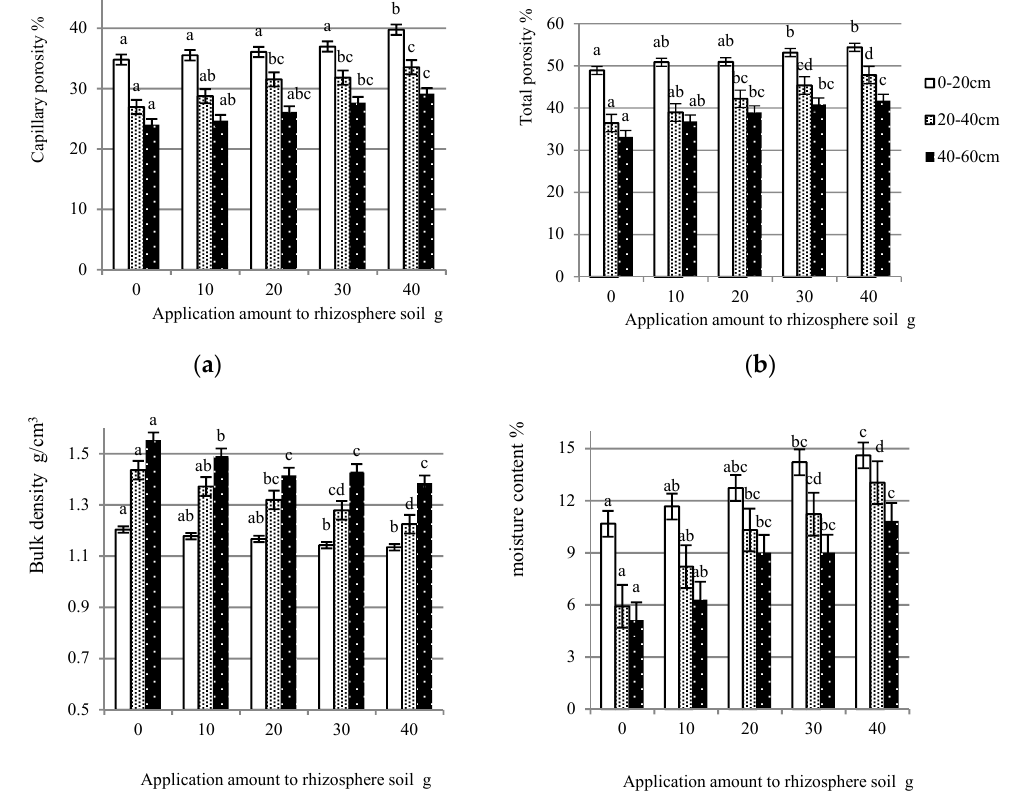
Figure 2. The effect of the application of yeast extract on the physical properties of rhizosphere soil from the three layers. ( a ) Capillary porosities of rhizosphere soil to which has been applied different amounts of yeast extract; ( b ) Total porosities of rhizosphere soil to which has been applied different concentrations of yeast extract; ( c ) Bulk densities of rhizosphere soil to which has been applied different concentrations of yeast extract; and ( d ) Moisture contents of rhizosphere soil to which has been applied different concentrations of yeast extract. In each graph, the bars with the same color and no common letters have a significant difference at the 0.05 level.